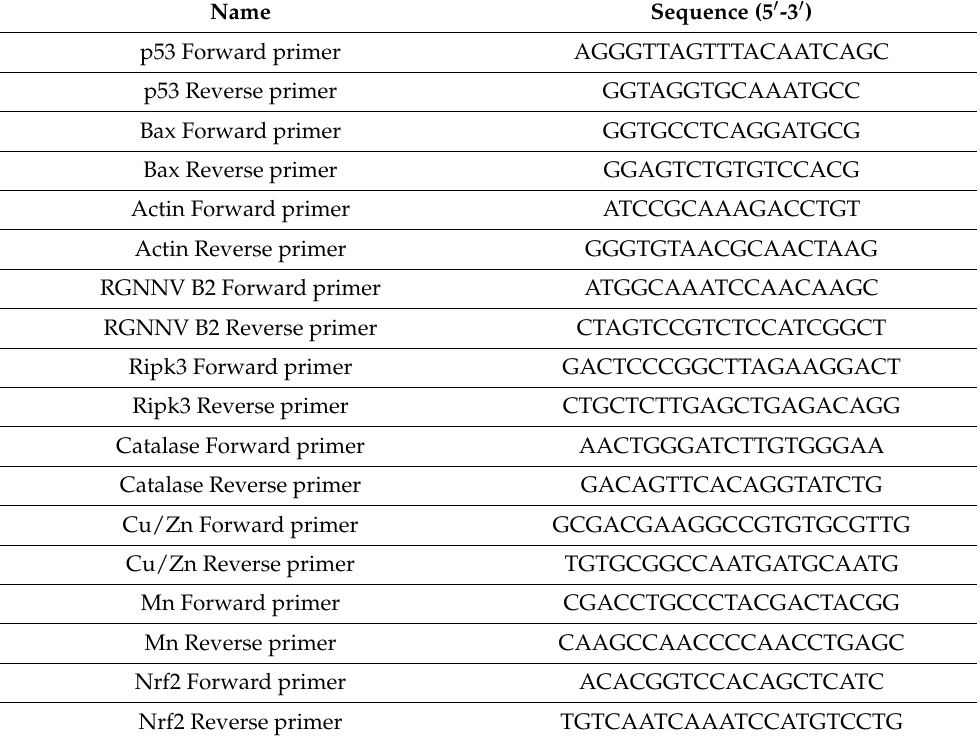
Table 2. Primer used in the